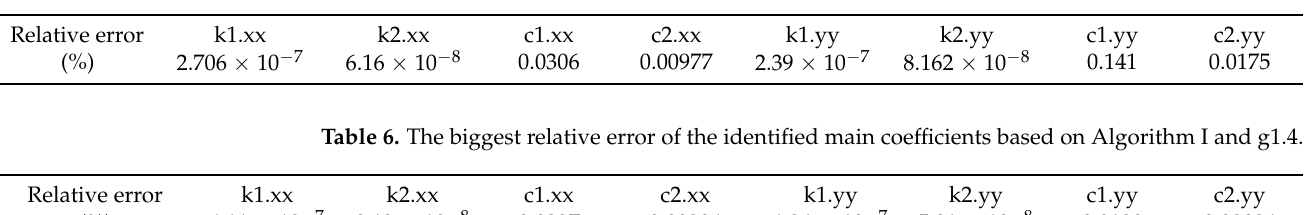
Table 5. The biggest relative error of the identified main coefficients, based on Algorithm I and g1.1.